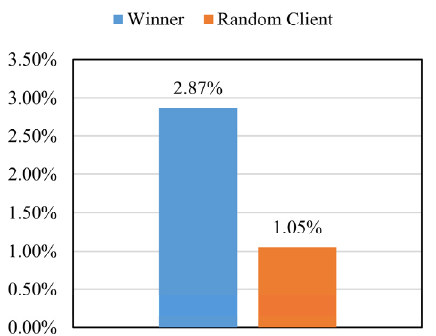
Figure 9. Increased accuracy of different participants.